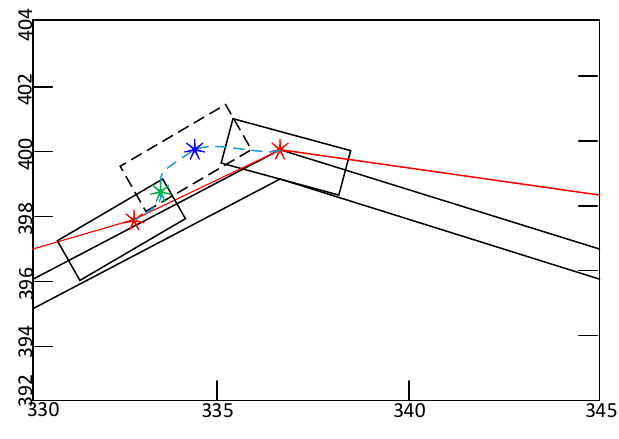
Figure 28. Rectification of path.